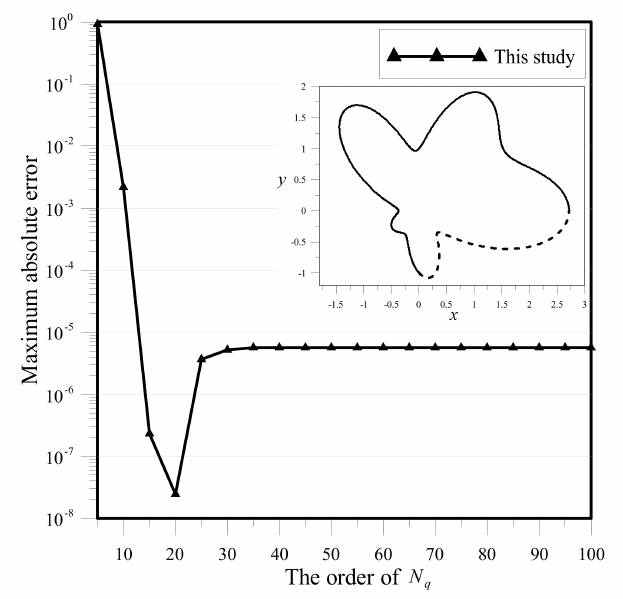
Figure 7. N q versus the maximum absolute error.